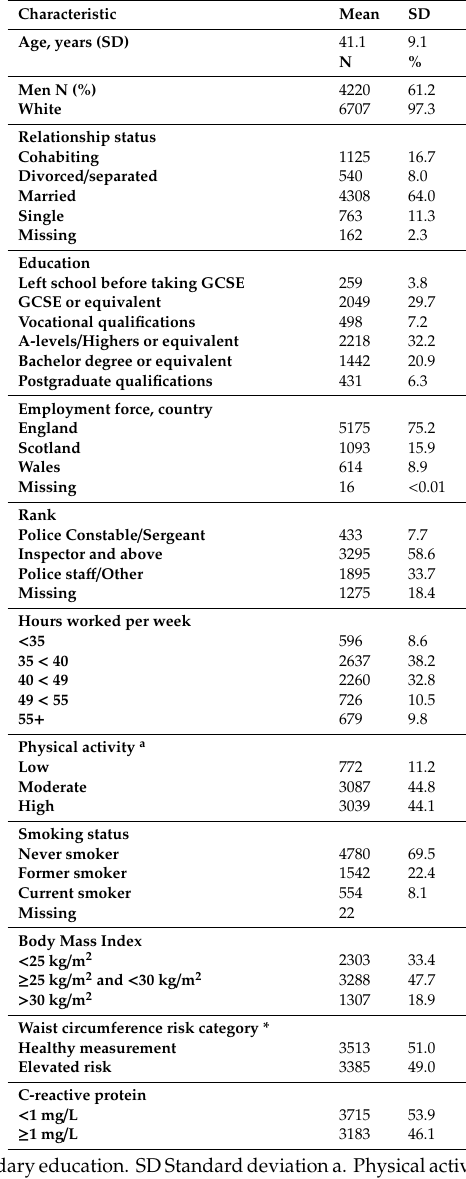
Table 1. Characteristics of the Airwave Health Monitoring Study participants with dietary data available 2007–2012 ( n = 6898).